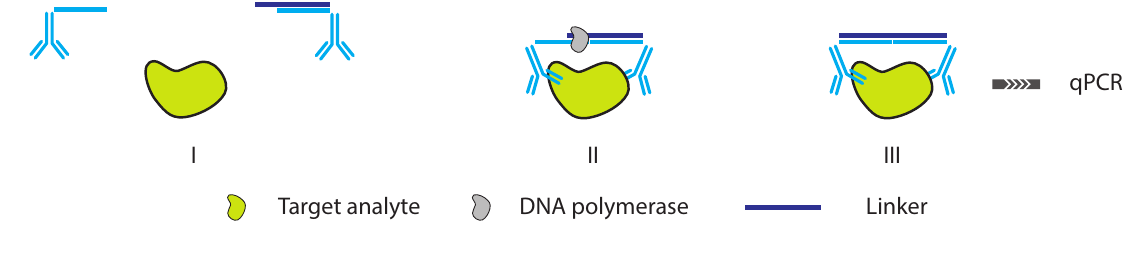
Figure 13. A schematic overview of the PEA assay [53].